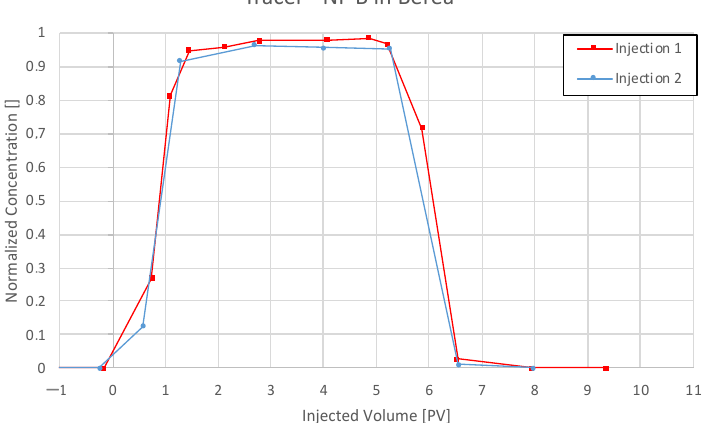
Figure 12. Tracer breakthrough comparison for NF B in Berea shows both breakthroughs at 0.9 PV. Particle size analysis suggests that larger particles arrive earlier in both injection steps. Table 8. Adsorption calculation via mass balance following concentration calculation using UV–Vis spectroscopy data for nanofluid B in Berea and Keuper outcrop core.